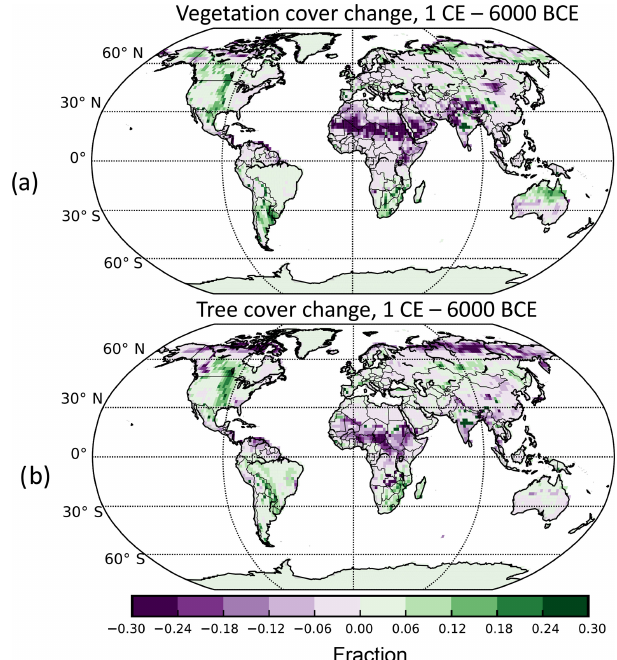
Figure 5. Change in vegetation fraction (a) and tree cover frac- tion (b) at 1CE relative to 6000BCE in the TRAFc